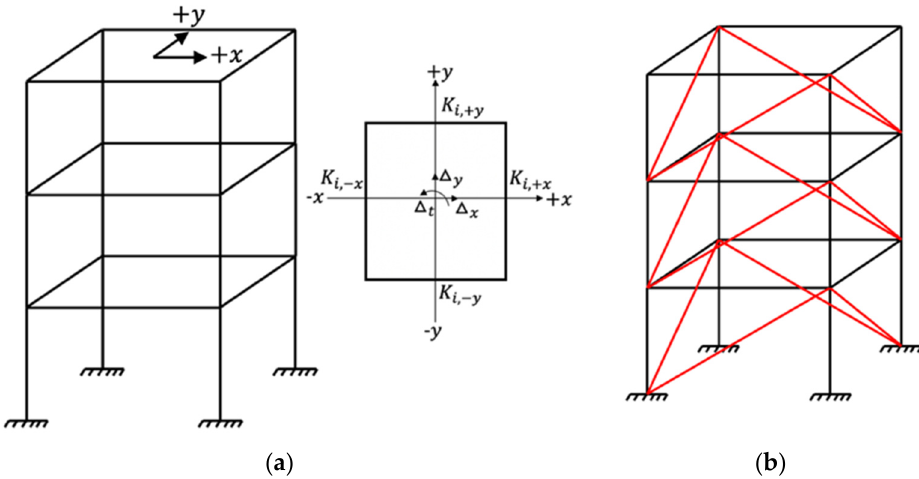
Figure 8. Diagram of steel frame model: ( a ) original system and plan view; ( b ) modified system with BRBs (marked as red color).